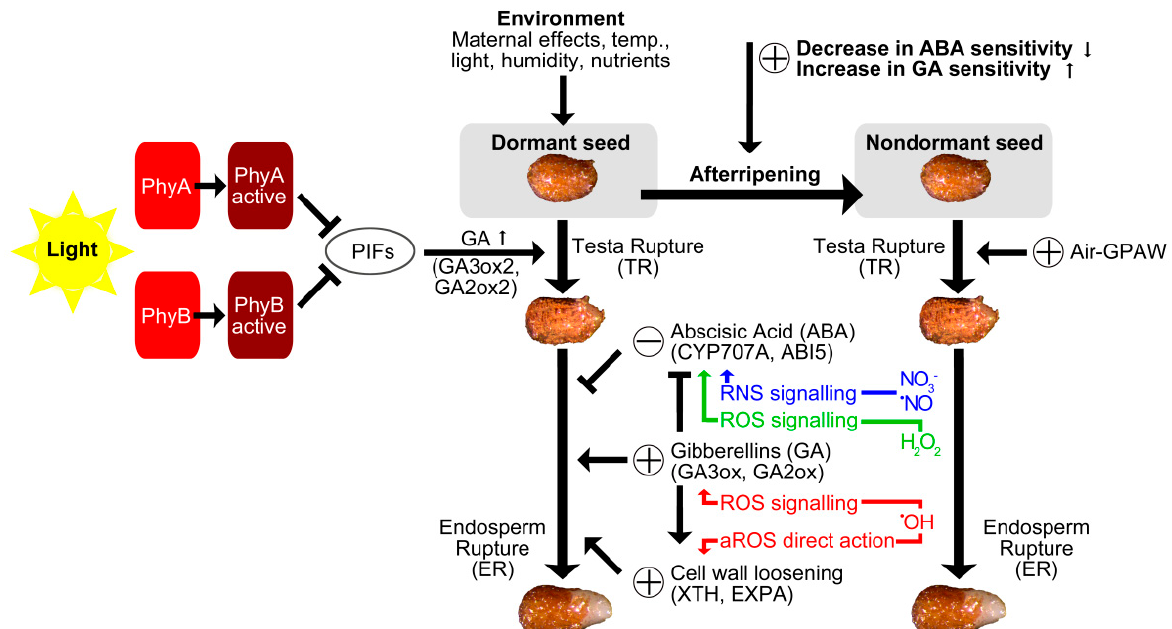
Figure 7. Schematic presentation of ROS and RNS signalling pathways. Phytochromes are activated and deactivated by red and far red light. Active phytochromes trigger cascades that lead to germination. Dry storage (after-ripening) reduces the dormancy status and enables seeds to complete germination under favourable conditions. Reactive oxygen species (ROS) and reactive nitrogen species (RNS) perform oxidative and nitrosative signalling to induce seed germination and release dormancy, particularly through cross-talk with plant hormones such as abscisic acid (ABA) and gibberellin (GA). Apoplastic ROS (aROS) mediates endosperm weakening and radicle growth via the direct chemical scission of cell walls [19,31].